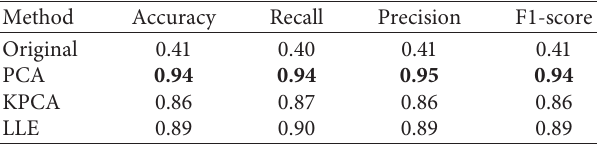
Table 1: Performance of HFOs classification with different di- mension reduction methods.